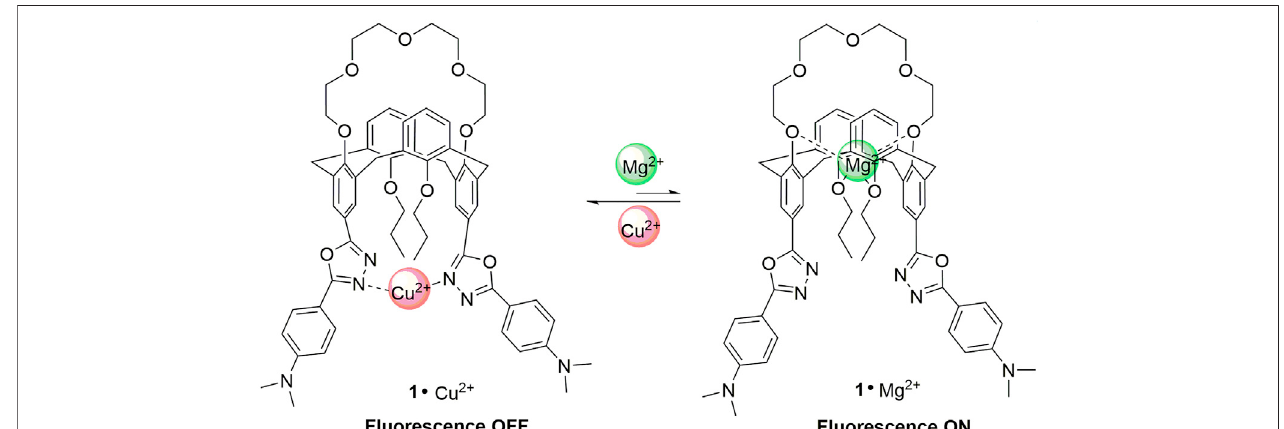
FIGURE 6 | The complexation of 1 with Cu 2+ and Mg 2+ ions.